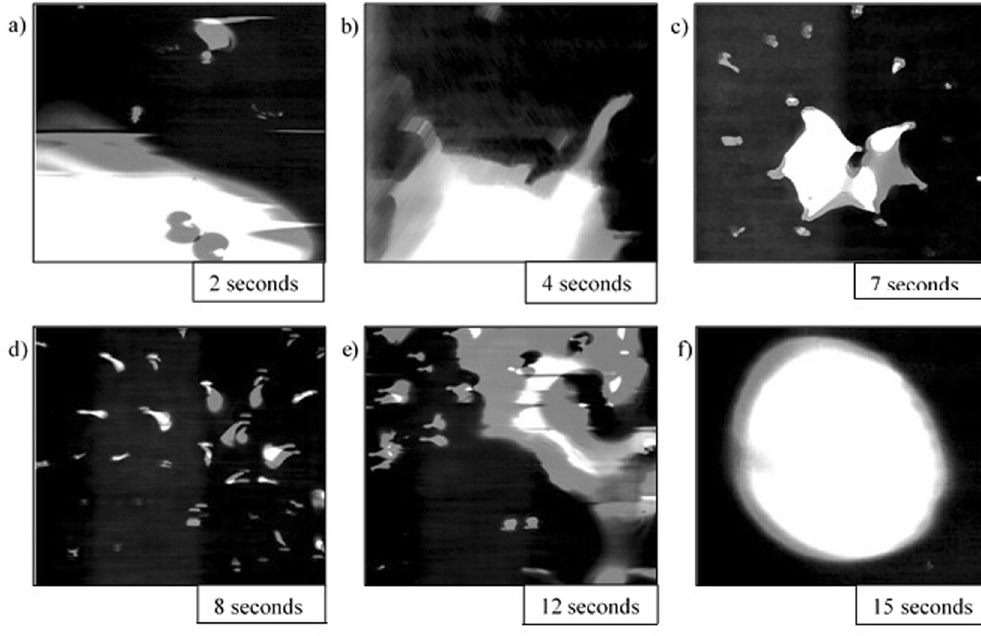
Figure 5. Time step images of the 4% FeAl experiment as seen in the HT-CSLM. In focus metal phases appear as lighter in grey scale and the molten metal oxide phase is seen as black. ( a–f ) Shows the cycle of perturbation- emulsification and finally coalescence.